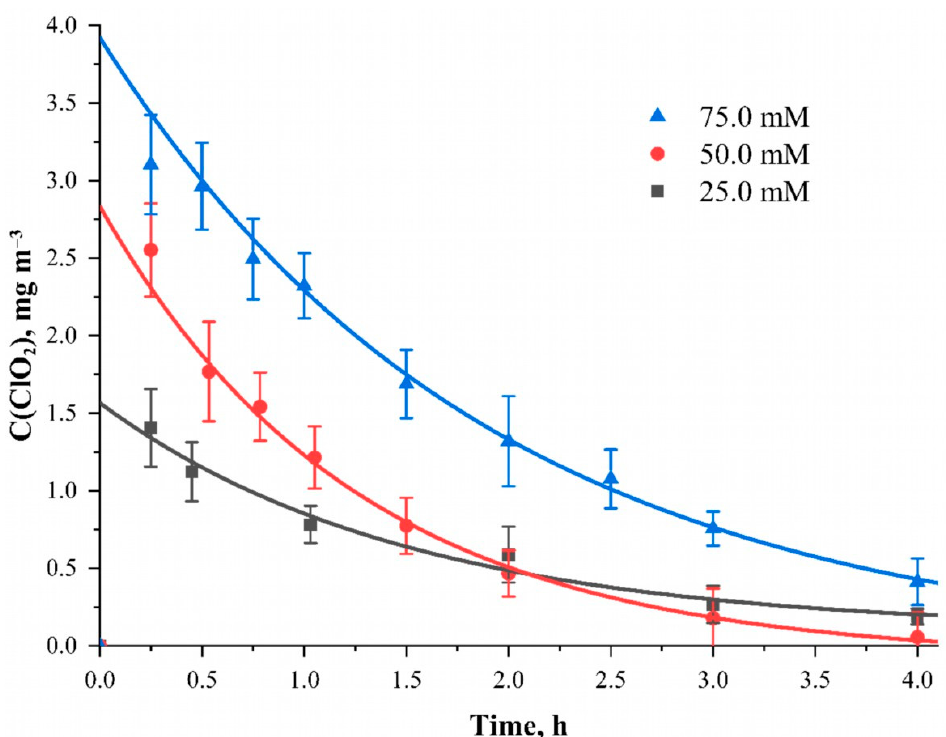
Figure 4. The dependence of the ClO 2 concentration inside the camera when applying a NaClO 2 solution of different concentrations to the material surface at the time after the start of the reaction. Solvent—95 wt. % water solution of ethanol; material—cotton cellulose fabric with the content of phosphorus-containing groups equal to 0.802 ± 0.082 mmol g –1.